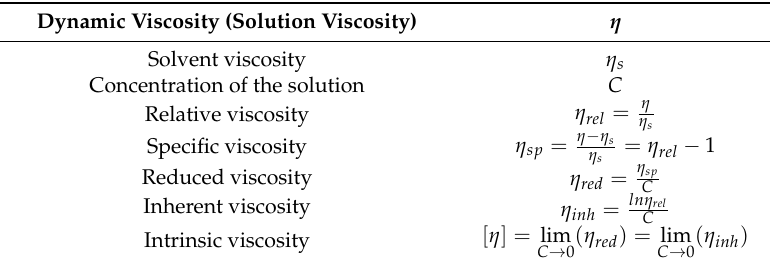
Table 2. Viscosity Table 2. Viscosity nomenclature.